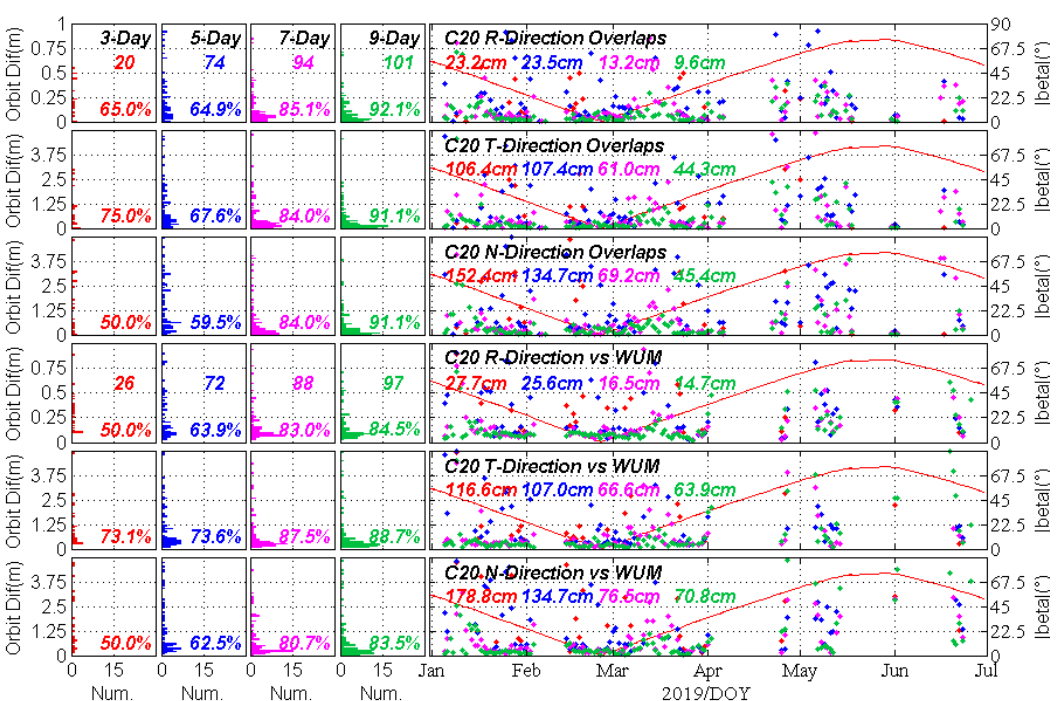
Figure 11. The results of SLR-only orbit determination for C20.